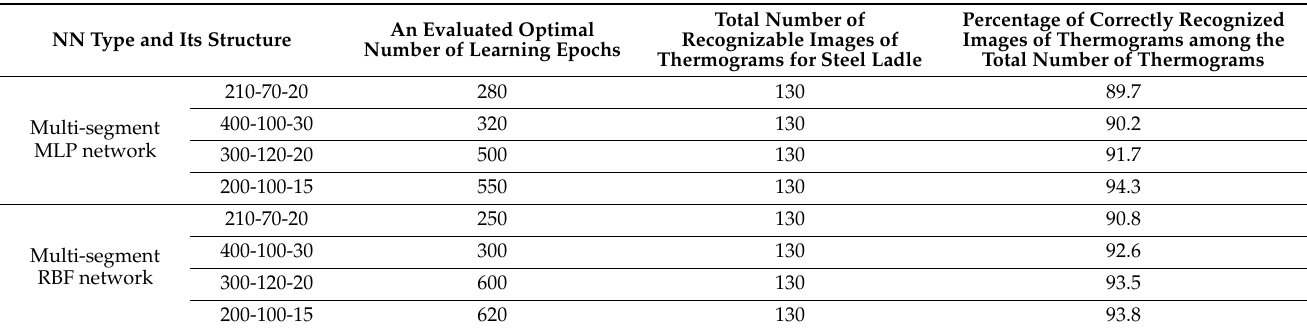
Table 2. Comparative results of the functioning of the developed neural networks.